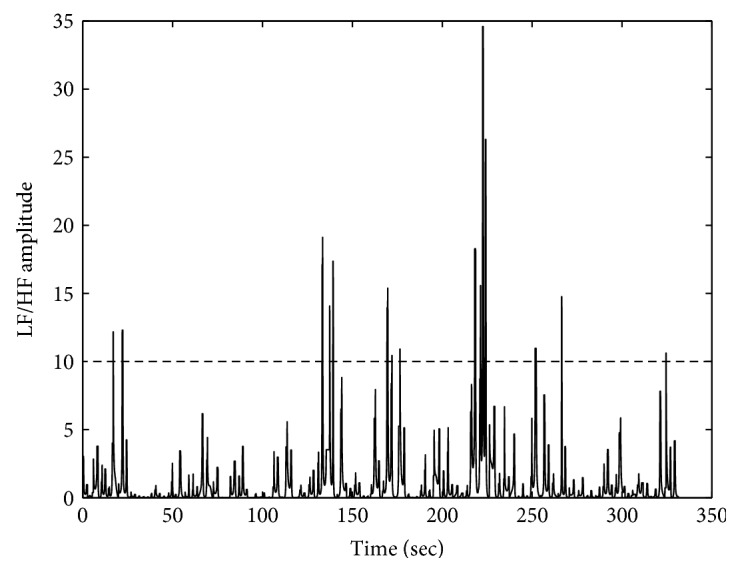
Example of F[LFwt/HFwt(t)] with the decision threshold.